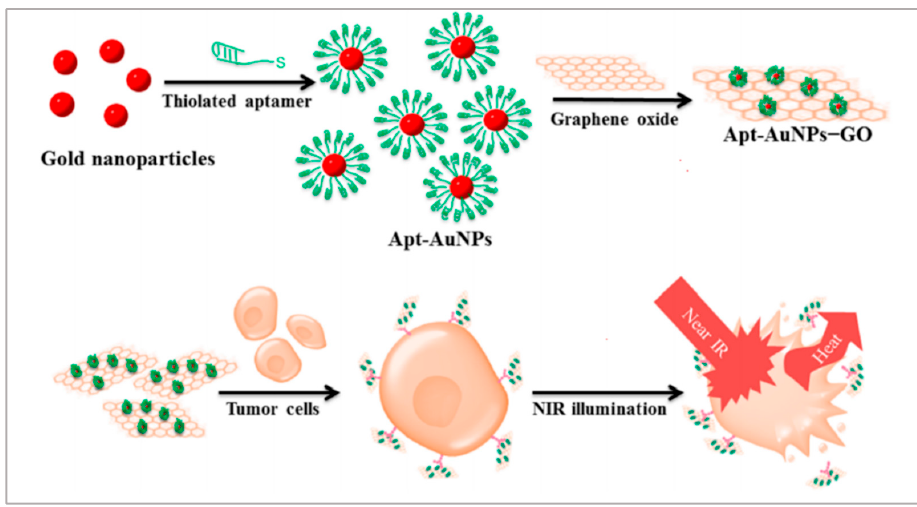
Figure 2. Schematic representation of the preparation of Apt-AuNP-GO and its application with NIR laser irradiation for photothermal therapy of cancer cells. Reprinted with permission from [78]. Copyright © 2015 American Chemical